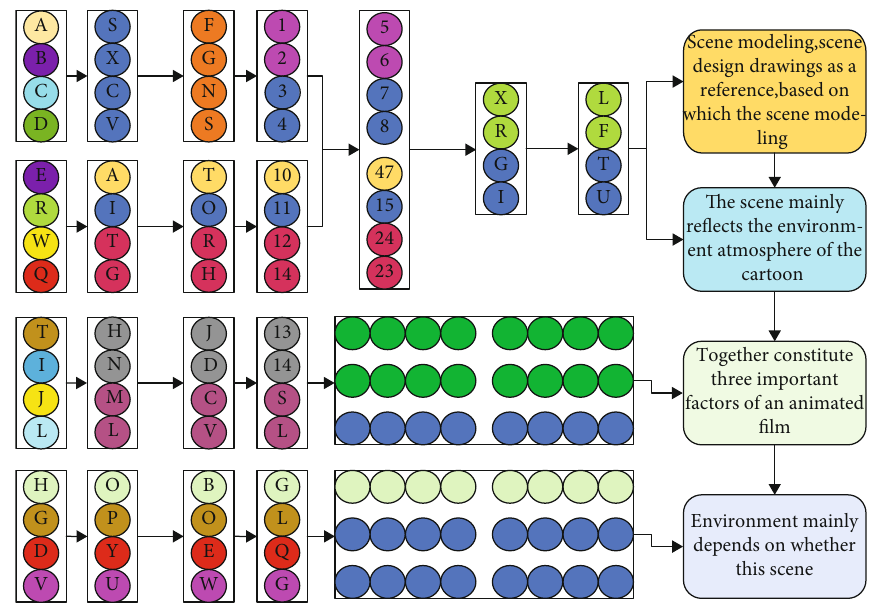
Figure 3: Fast projection method for signal